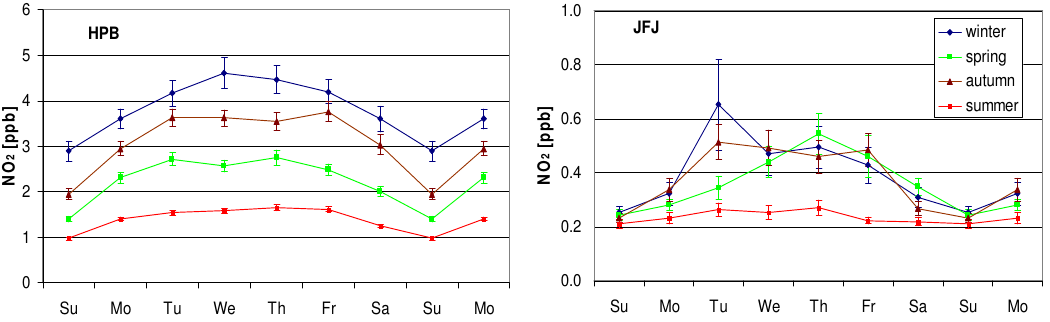
Fig. 15. Weekly variation of NO 2 for the different seasons at the respective “DACH” sites, blue: winter; red: summer, brown: autumn, green: spring. The errors bars indicate the standard error of the mean.